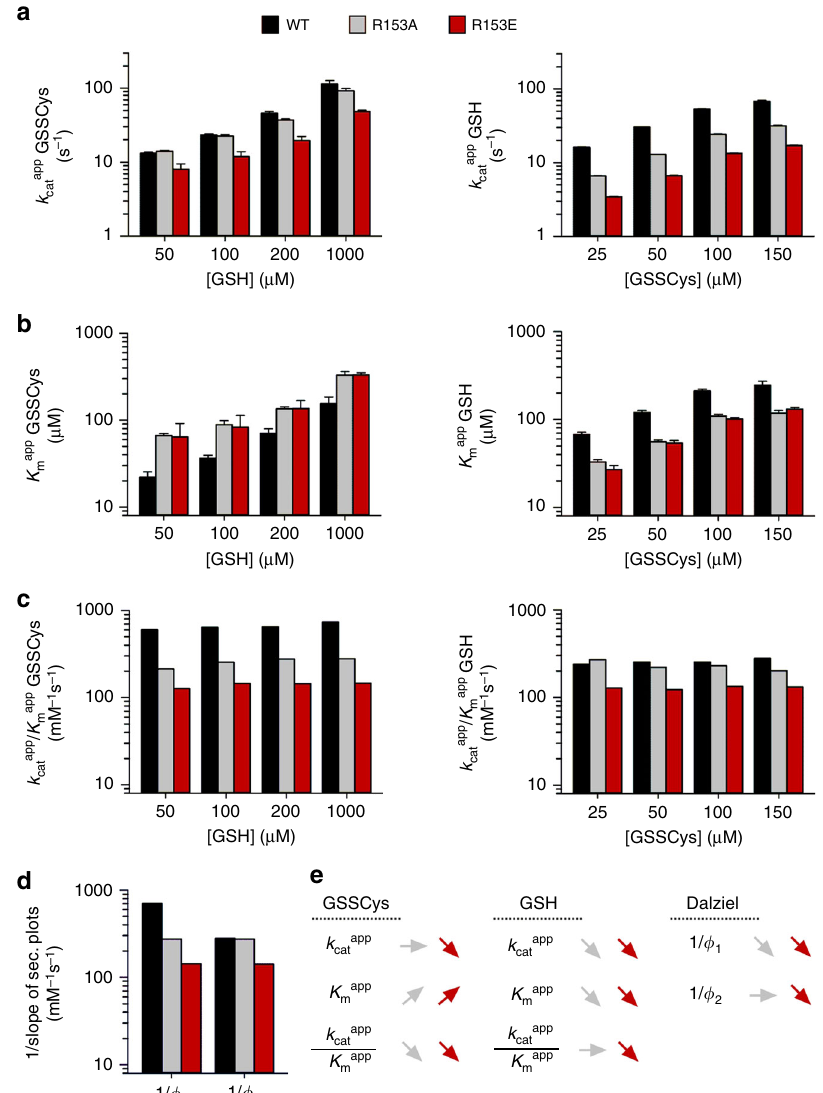
and K app values of ScGrx7 wild-type enzyme cat m and K app values from panels a and b are listed in cat m